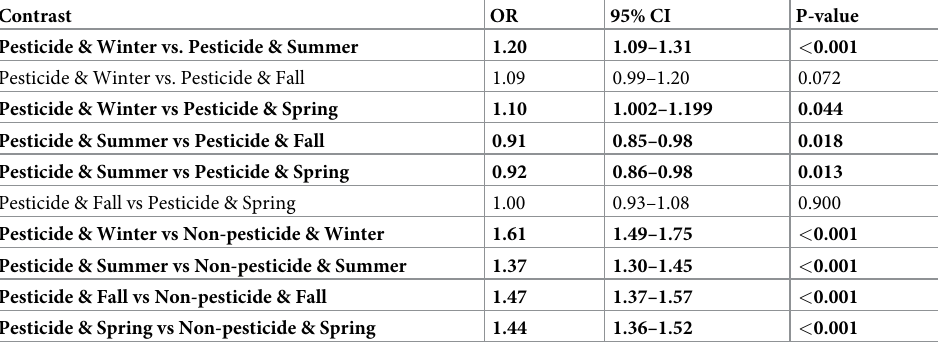
� Contrasts based on model presented in Table 3.